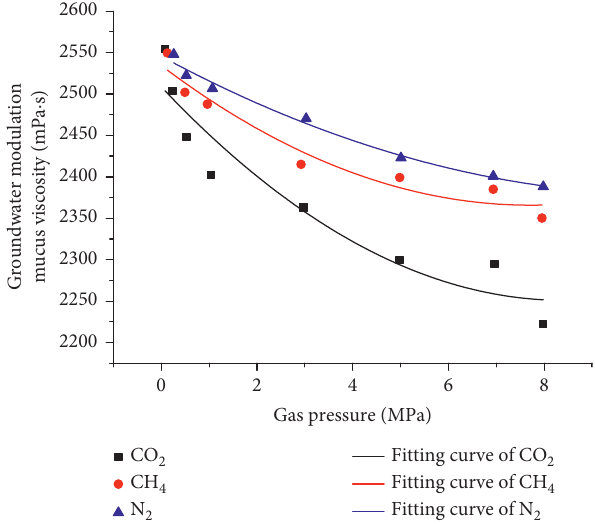
Figure 6: Curve of the viscosity of CMC-Na prepared using groundwater at different